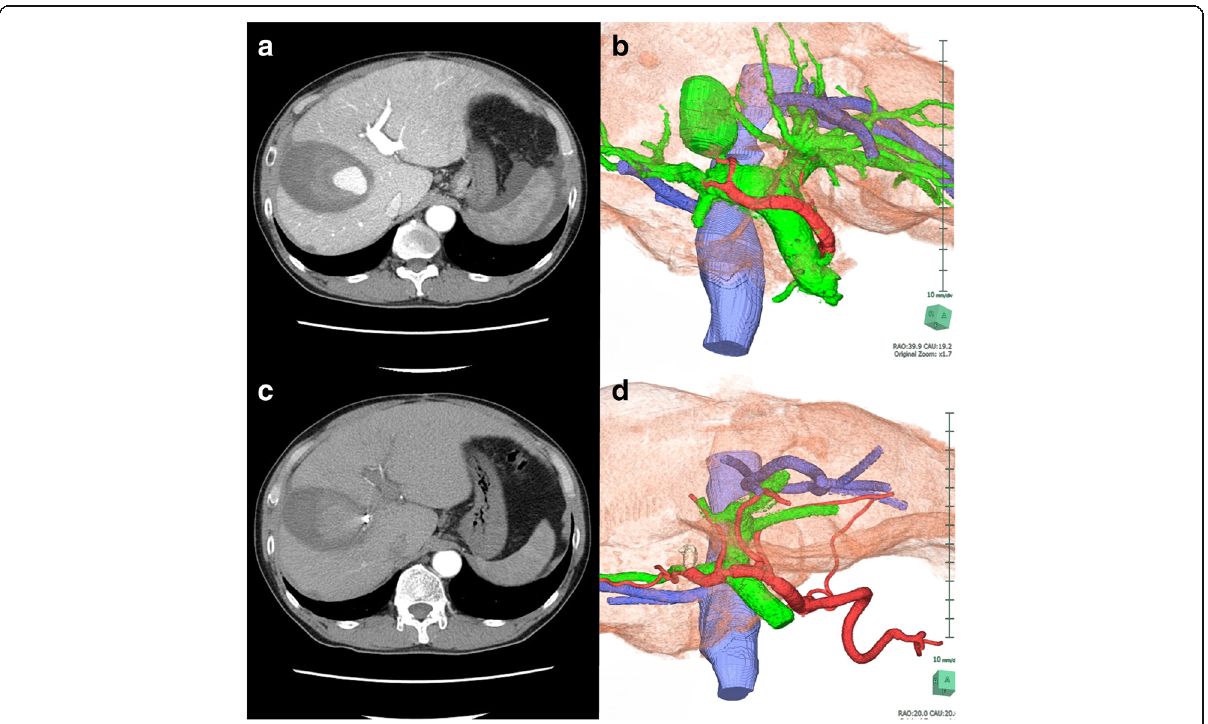
Fig. 6 Imaging findings before and after IVR. a , b Imaging findings before IVR. Prior to IVR, the APF and PVA were detected by a dynamic CT and b 3D images. c , d Imaging findings after IVR. Three days after embolization, c dynamic CT and d 3D images clearly demonstrated both perfect interruption of the APF and disappearance of the